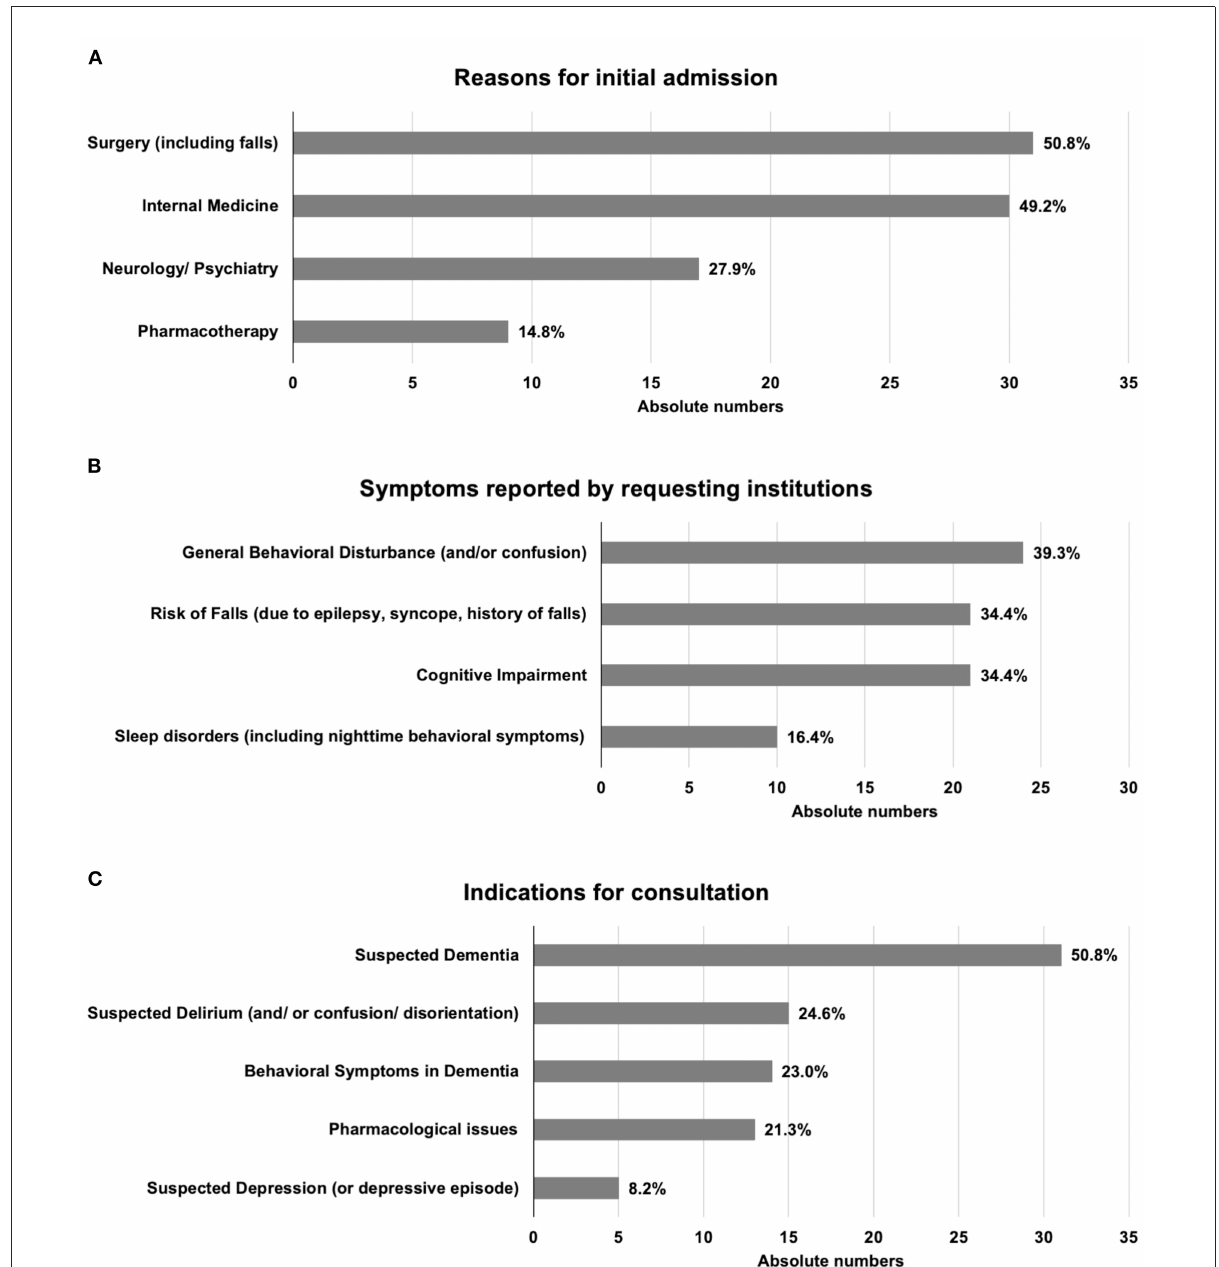
FIGURE2 Clinical history and indications for consultations. (A) Reasons leading to initial admission of the patients. (B) Symptoms reported by requesting institutions. (C) Specific indications for consultation. Total numbers sum to > 100% as multiple items could be reported for one patient.